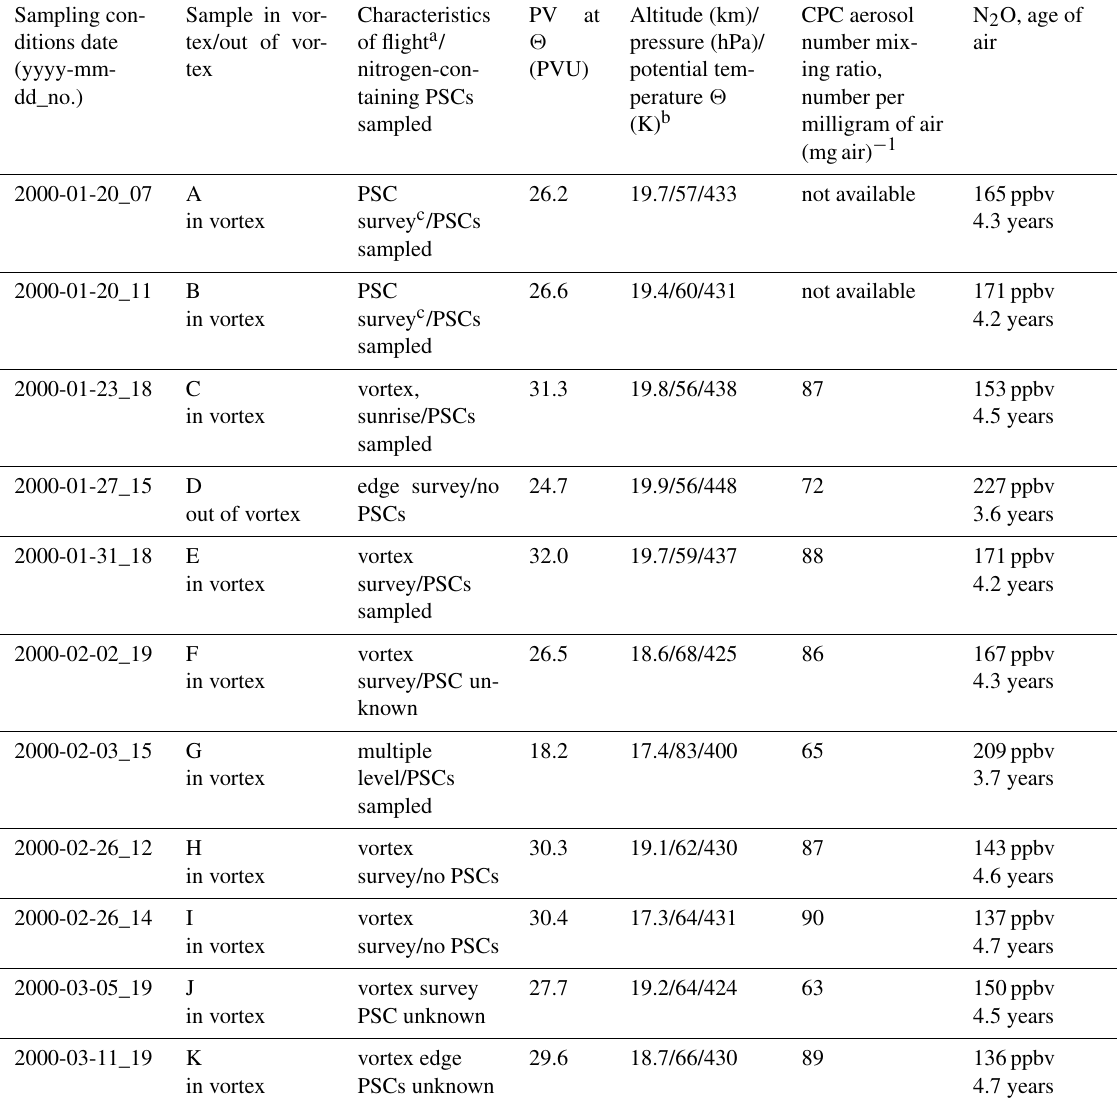
Table 1. Sampling